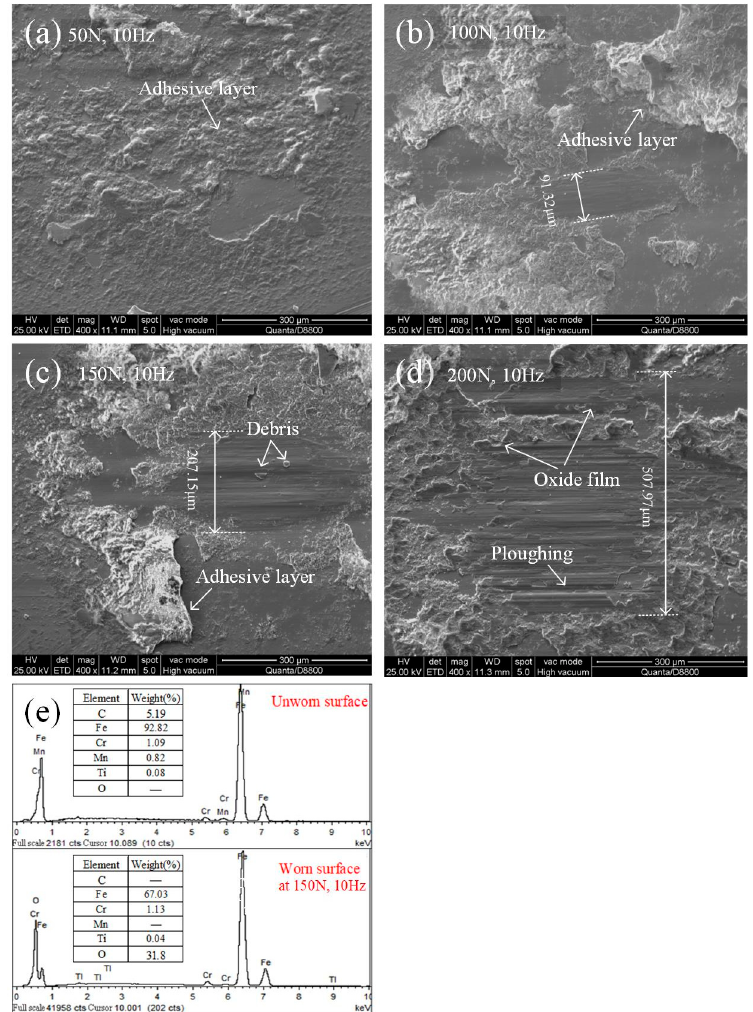
Figure 11. The surface worn SEM micrographs of specimen at loads of: ( a ) 50 N, ( b ) 100 N, ( c ) 150 N and ( d ) 200 N; and ( e ) EDS results of unworn surface and the worn surface at 150 N, 10 Hz.